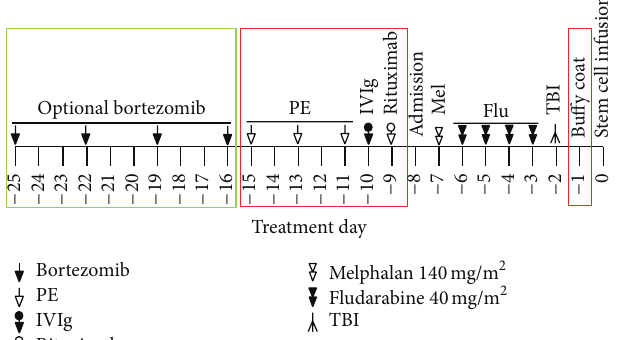
Figure 1: Desensitization approach for patients with DSAs undergoing haploidentical stem cell transplantation at MD Anderson Cancer